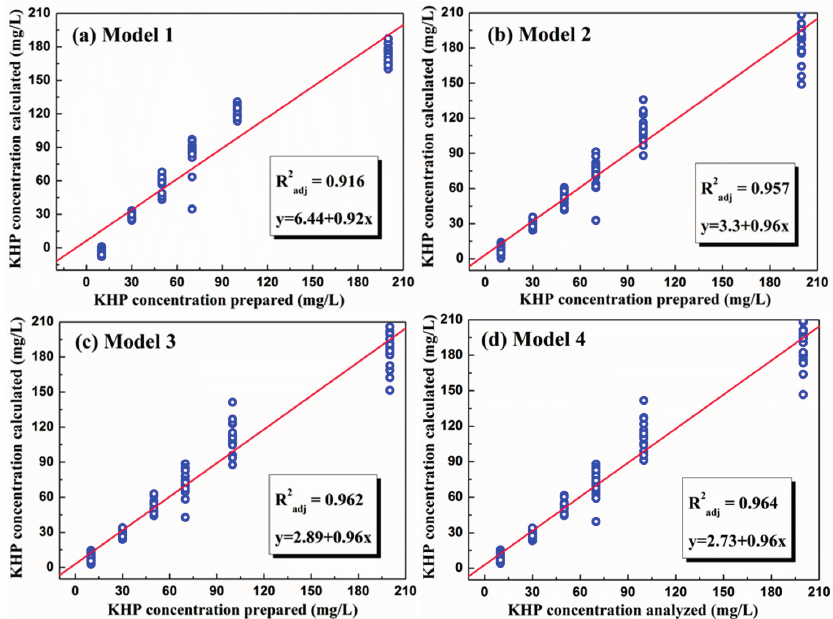
Figure 3. Relationship between the KHP concentration prepared (standard solution) and calculated